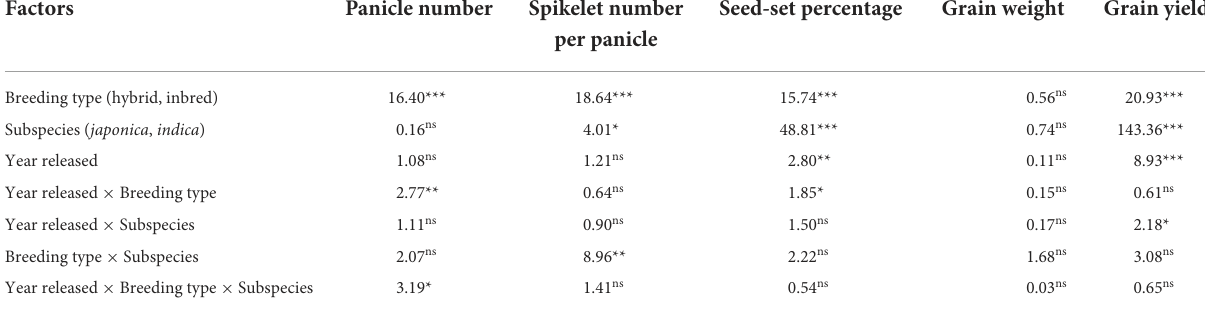
TABLE 1 Analysis of variance (ANOVA) of yield traits in rice.